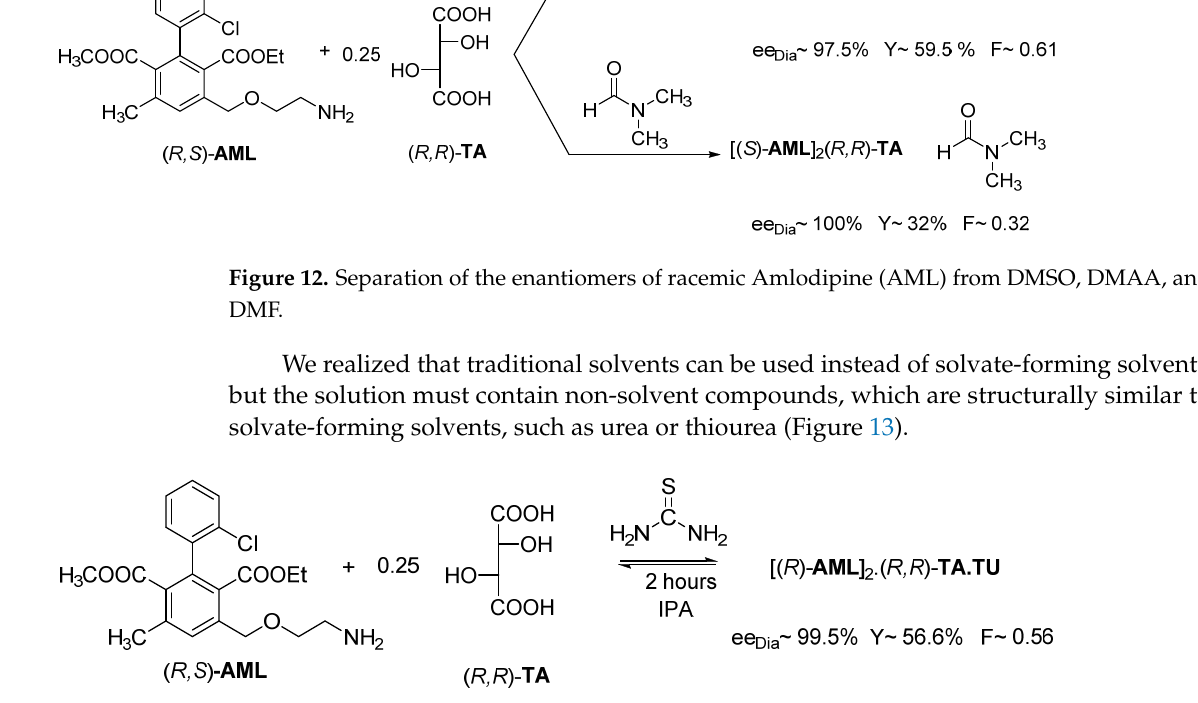
Figure 13. Resolution of racemic Amlodipine with ( R , R )-tartaric acid in isopropyl alcohol by adding thiourea. The kinetic control takes place in 2 h.